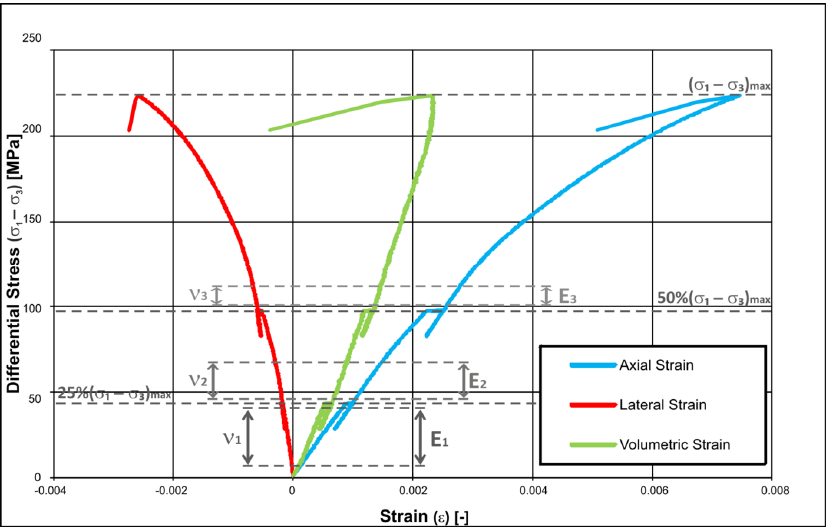
Figure 10. Characteristics of differential stress–axial, lateral and volumetric strain obtained in viscoelastic creep tests for sample M-43-B.